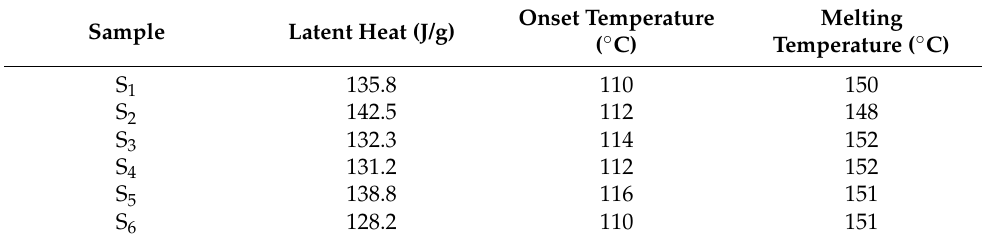
Figure 7. The DSC endothermic and exothermic curves of ternary nitrate and modified nitrate. Table 3. Result of latent heat, onset temperature, and melting temperature.